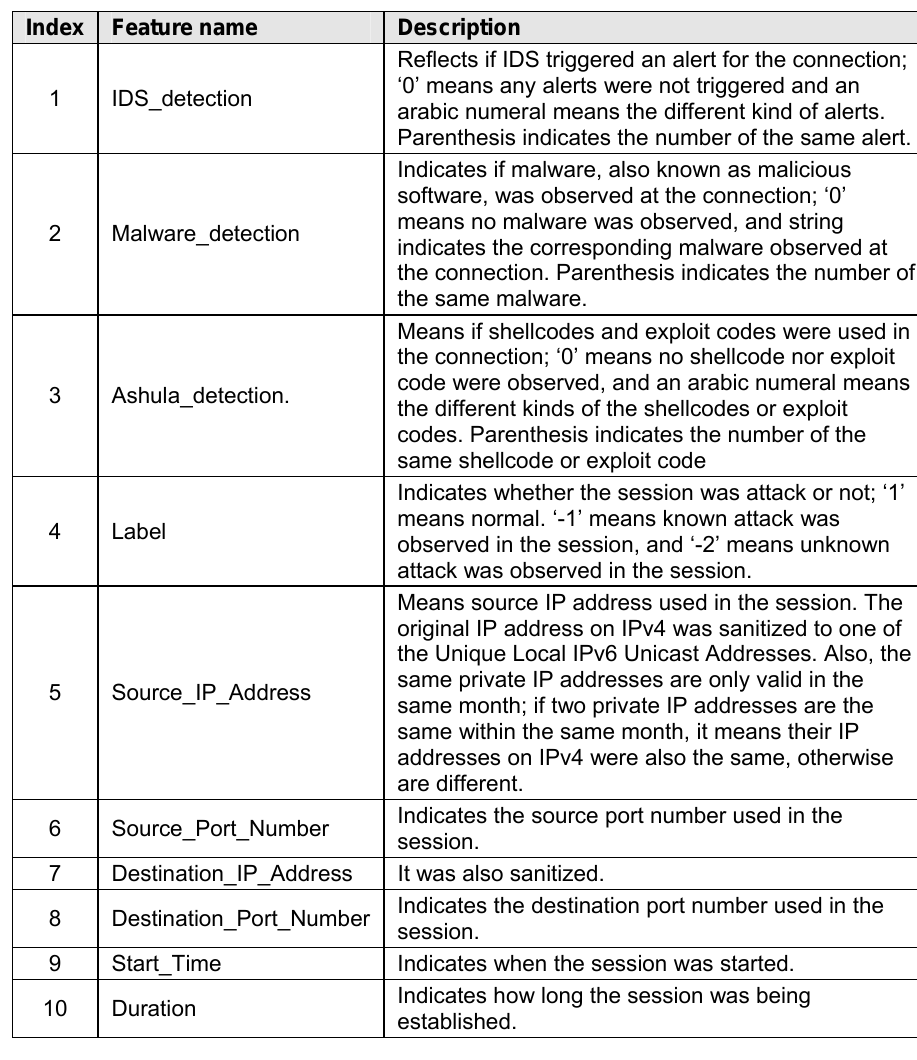
Table 7 – Additional features in Kyoto 2006+ dataset Таблица 7 – Дополнительные атрибуты в Kyoto 2006+ базе данных Табела 7 – Додатни a трибути у Kyoto 2006+ бази